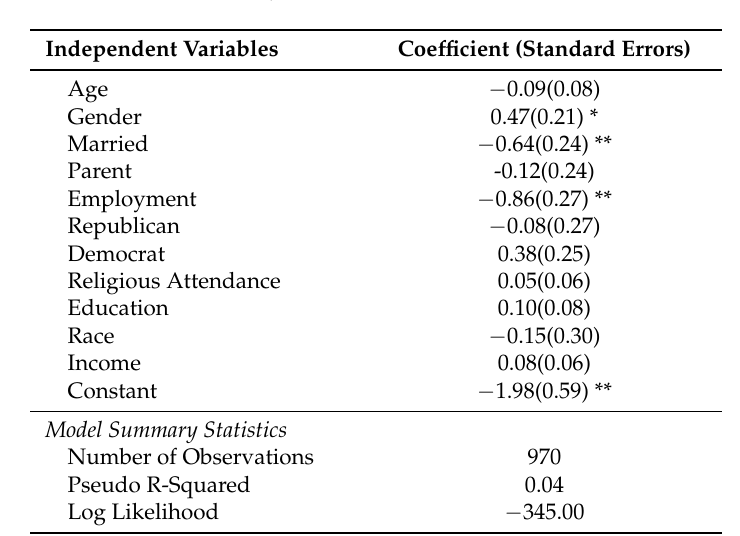
Table 1. Logistic regression evaluating which individuals are most likely to post online comments in 2008 (Pew Internet & American Life Project [32]).